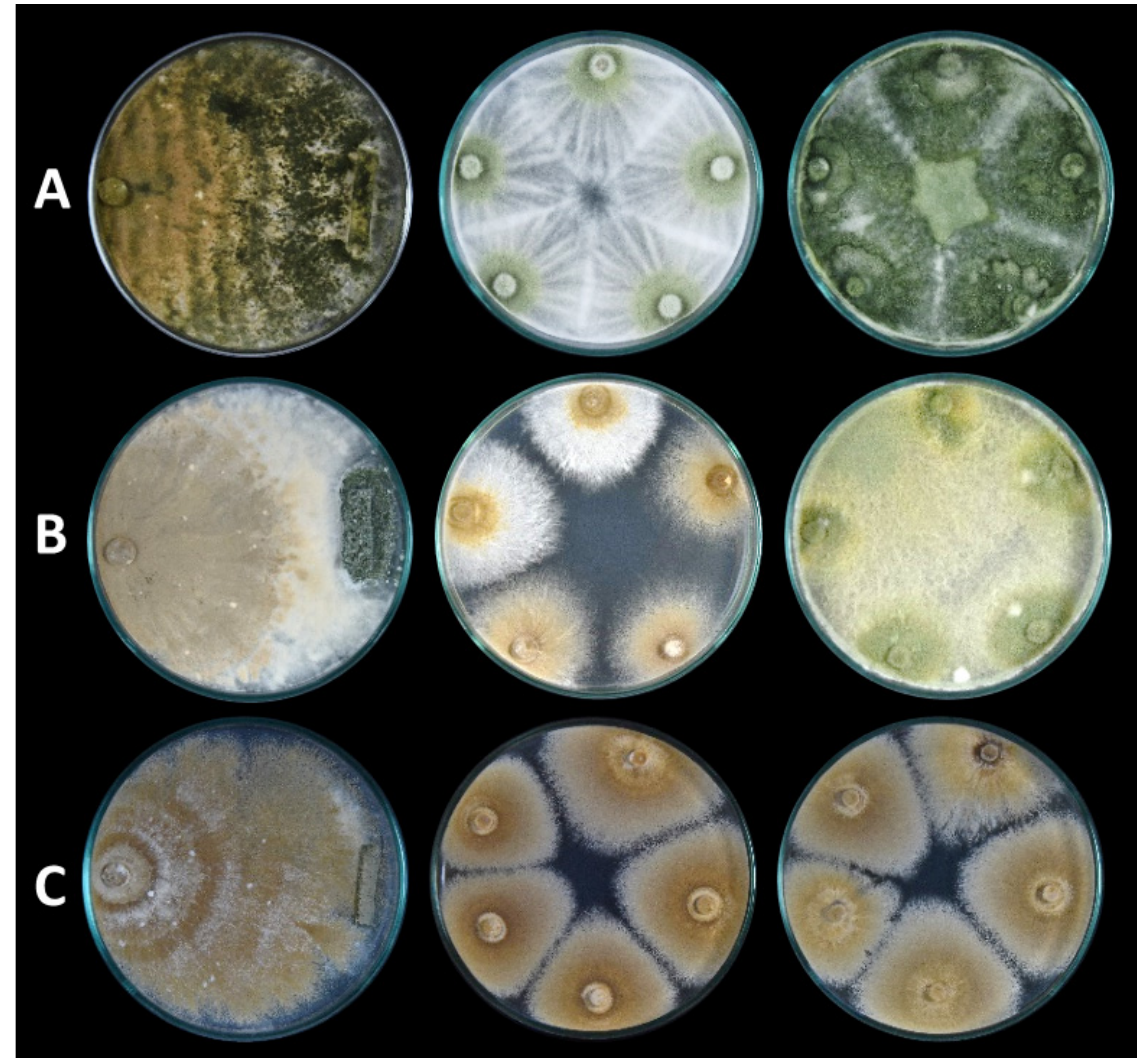
Figure 1. Mycoparasitism tests against Moniliophthora roreri . ( A ) Example of a test with a high mycoparasitism level ( Trichoderma longibrachiatum strain F14M3) (100%). A_Left: dual culture at 21 days after inoculation. A_Center and A_Right: discs taken from A_left plate showing Trichoderma growth. ( B ) Example of a test with a medium mycoparasitism level ( T. parareesei strain CRSF3_C2) (50%). B_Left: dual culture at 21 days after inoculation. B_Center: discs with M. roreri growth taken from B_left plate. B_Right: discs taken with Trichoderma growth from B_left plate. ( C ) Example of a test with low mycoparasitism level ( T. longibrachiatum strain F21M5) (0%). C_Left: dual culture at 21 days after inoculation. C_Center and C_Right: discs with M. roreri growth taken from C_left